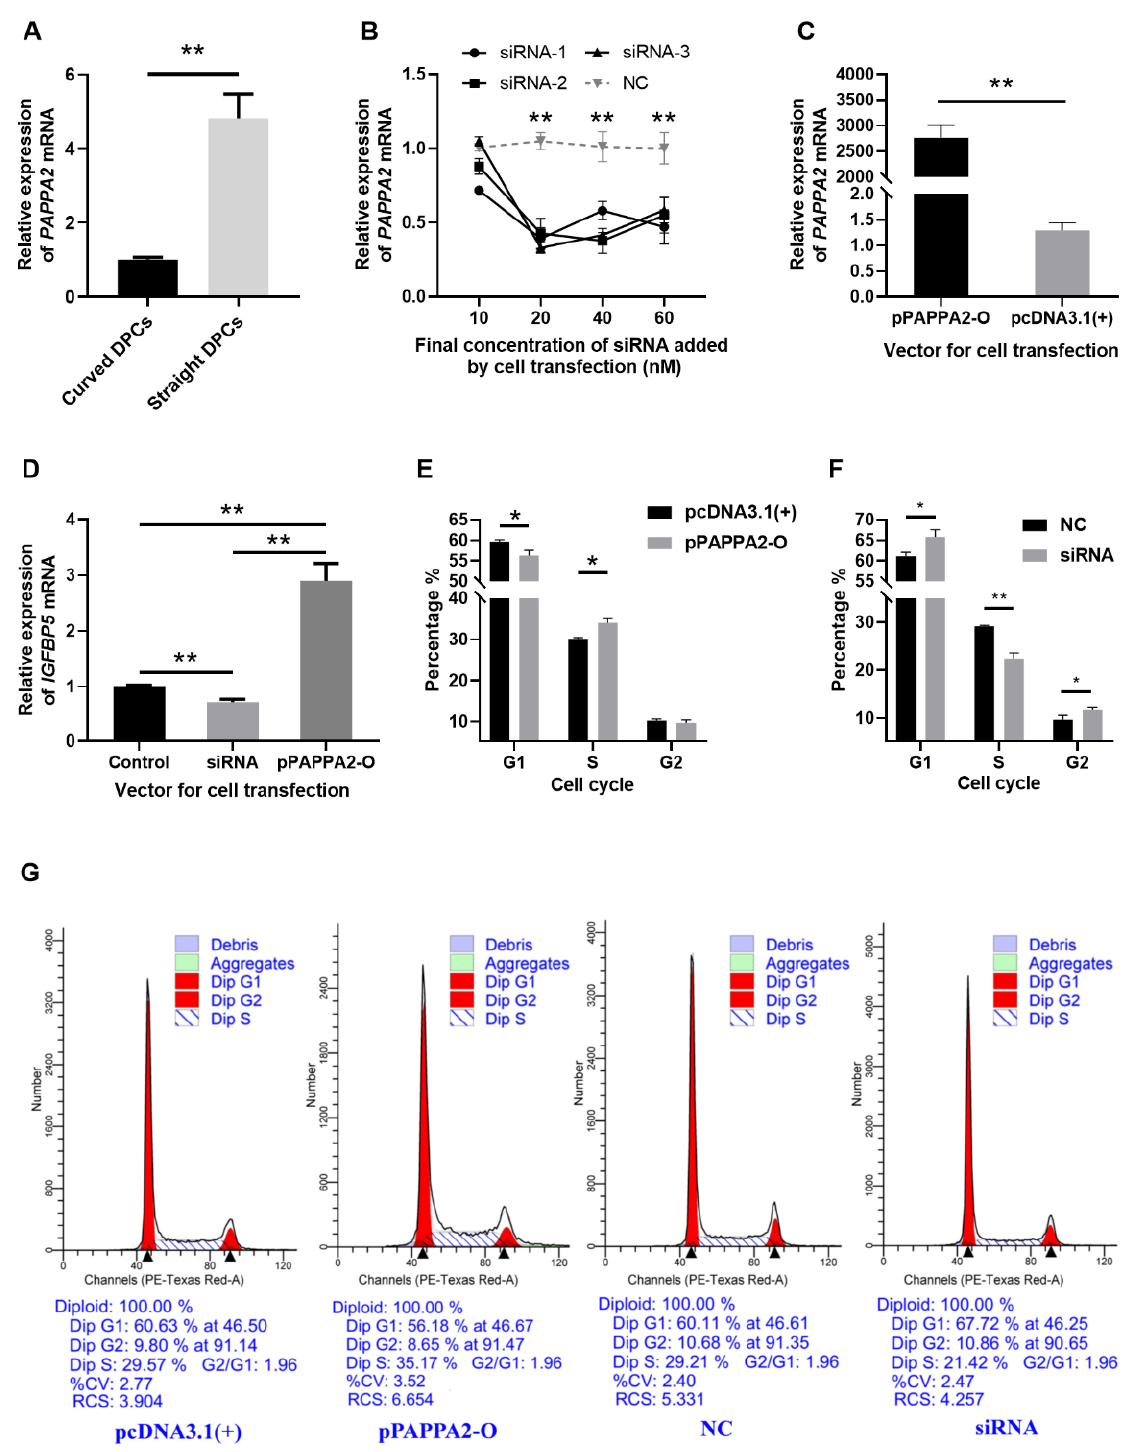
Figure 4. PAPPA2 was involved in the regulation of DPCs proliferation in Hu sheep. Note: ( A ): Relative expression of PAPPA2 mRNA in straight and curved dermal papilla cells (DPCs). ( B ): Relative expression of PAPPA2 after transfection with different concentrations of PAPPA2 siRNA-1/2/3 (with NC as control). ( C ): Relative expression of PAPPA2 after pPAPPA2-O transfection (with pcDNA3.1(+) as control). ( D ): PAPPA2 regulate the mRNA expression of insulin-like growth factor binding protein-5 ( IGFBP5 ). ( E , F ) show the cell cycle statistics of DPCs after PAPPA2 overexpression (transfected with pPAPPA2-O) and interference (transfected with siRNA-1/2/3). The Transfections of pcDNA3.1(+) and NC were used as controls for overexpression and interference, respectively. ( G ): The results of cell cycle analysis by ModFit3.1. “*” indicates significant difference ( p < 0.05) and “**” highly significant difference ( p <